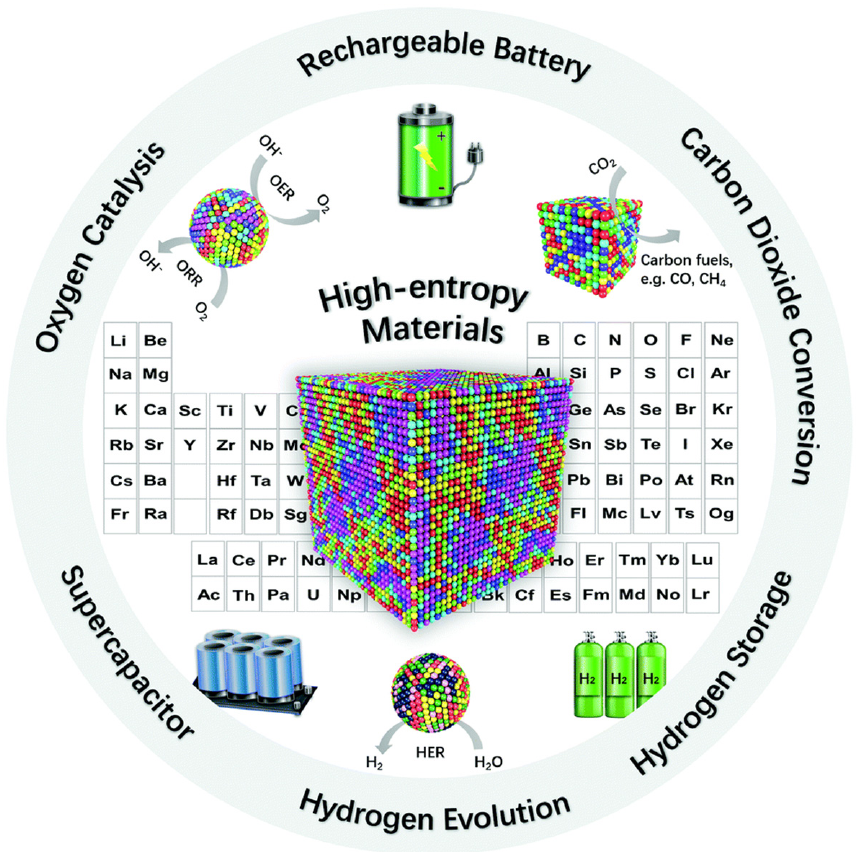
Figure 2. Fields of using high-entropy materials for energy conversion and storage purposes (Reproduced from [49] with permission from the Royal Society of Chemistry).